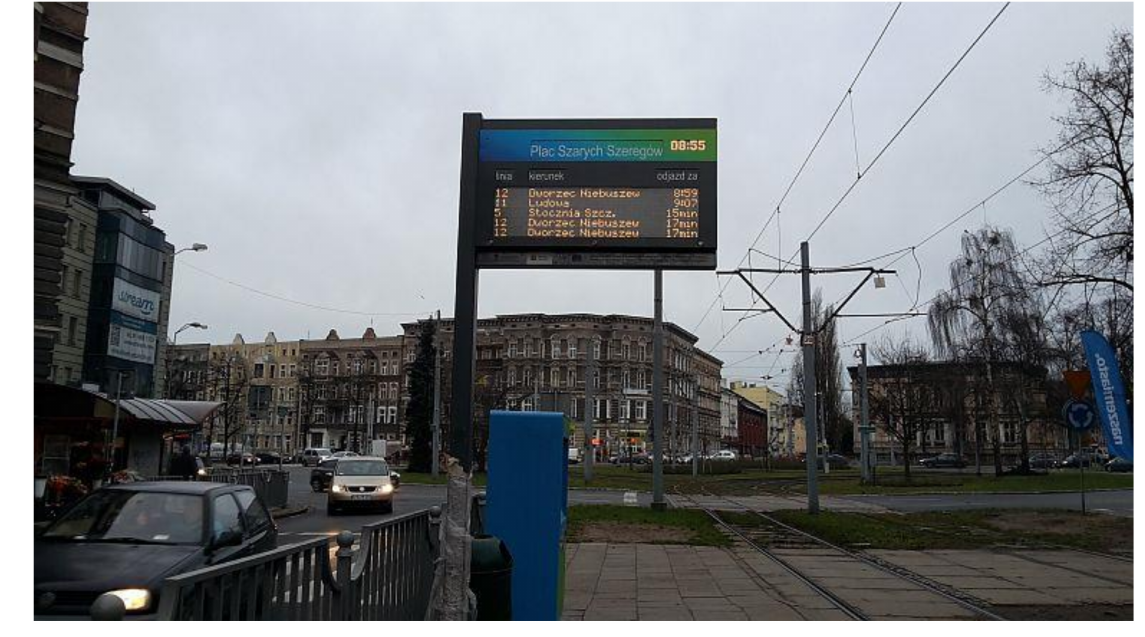
Figure 2. Information board.